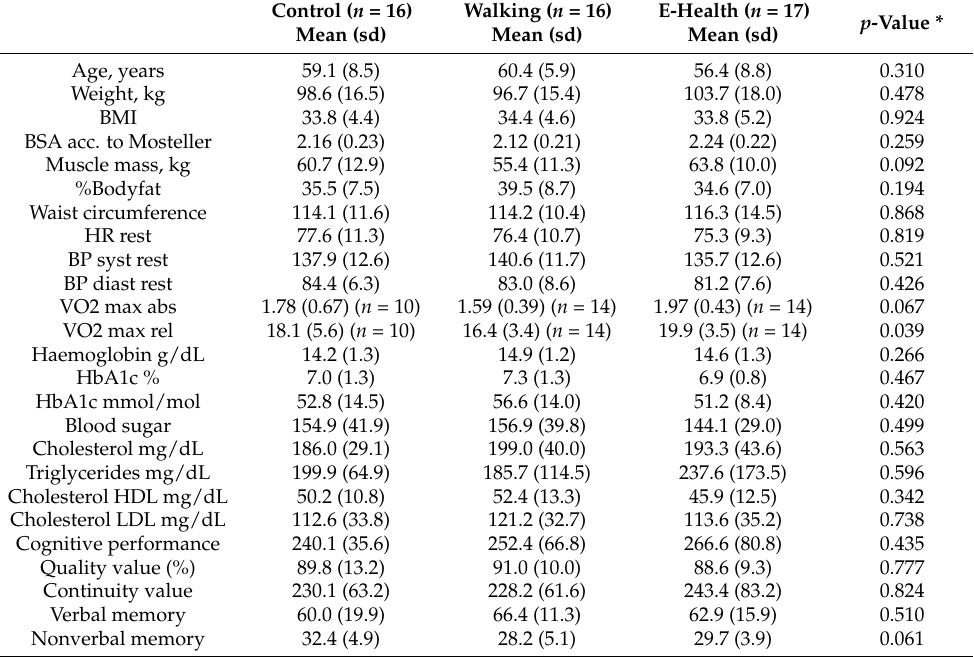
Table 1. Baseline characteristics and comparison of the three examined groups. BMI: Body Mass Index, BSA: Body Surface Area, HR: Heart Rate, BP: Blood Pressure, VO2 max abs: Oxygen uptake absolut, VO2 max rel: Oxygen uptake in